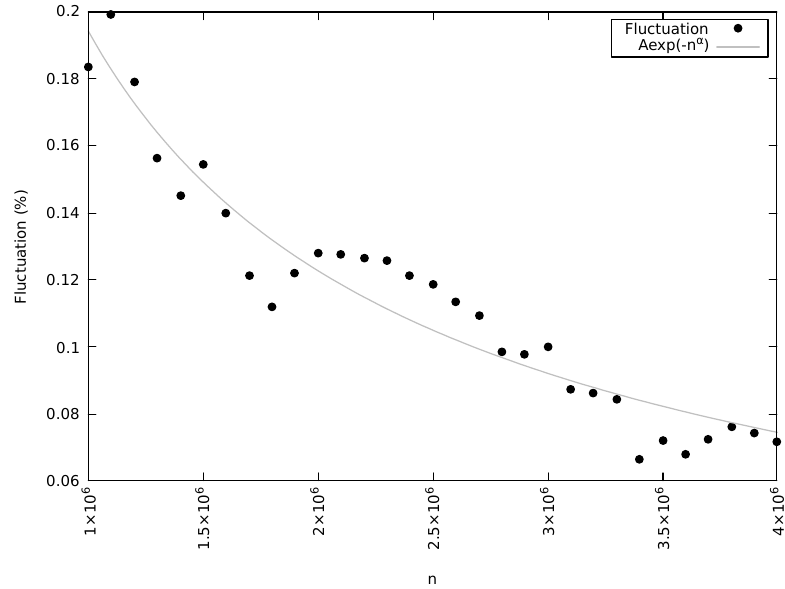
Figure 3. Fit of the function (8) to the